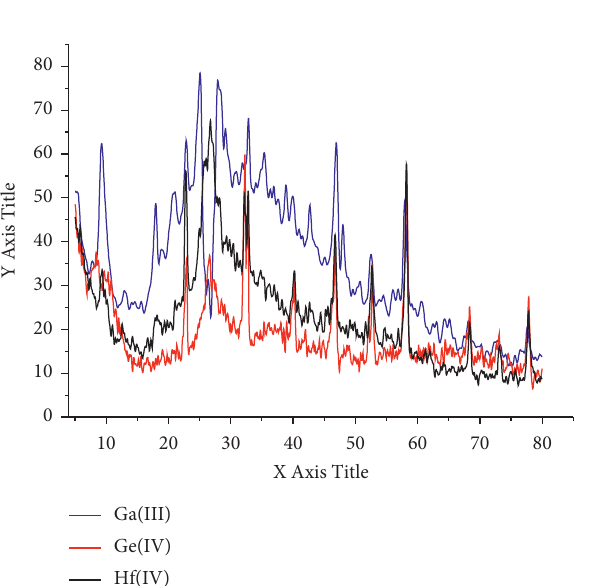
Figure 6: XRD patterns of Ga(III), Ge(IV), and Hf(IV) folate complexes.